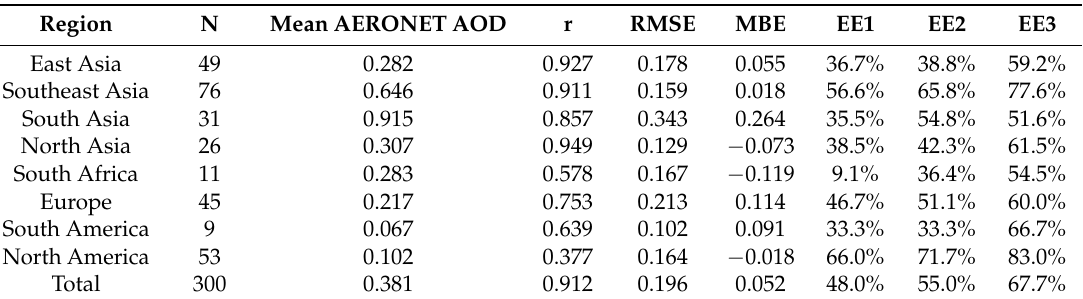
Table 2. Summary statistics for the entire dataset and each individual region: number of samples (N), correlation coefficients (r), RMSE, MBE and